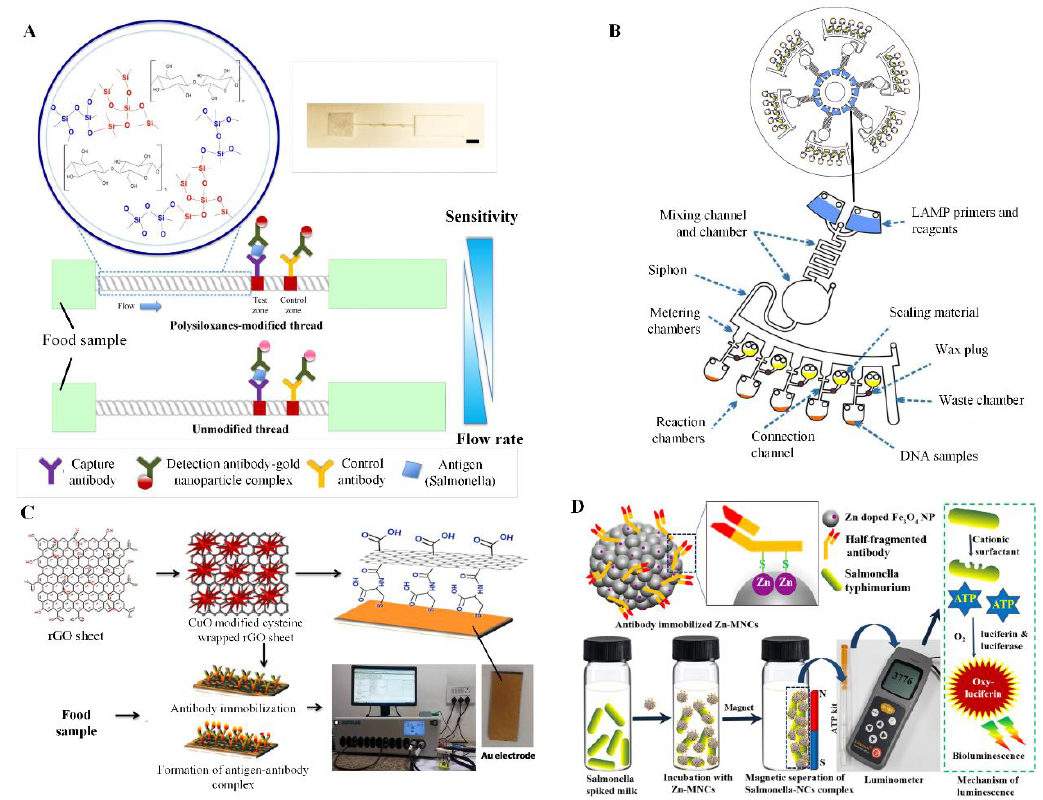
Figure 3. Other emerging point-of-care (POC) devices for food safety analysis. ( A ) A thread-based colorimetric device was developed for sensitive detection of Salmonella enterica in food samples such as milk, orange juice and lettuce. Adapted with permission from [86] © Elsevier (2018). ( B ) A disc-based loop-mediated isothermal amplification (LAMP) was developed for multiplexed fluorescent detection of foodborne pathogens, Escherichia coli , Salmonella sp. and Vibrio cholera , in chicken meat. Adapted with permission from [94] © Elsevier (2018). ( C ) A gold (Au) electrode coated with antibody immobilized graphene-wrapped copper oxide-cysteine hierarchical structure was introduced for sensitive electrochemical detection of Escherichia coli O157:H7 in food samples such as water, fruit juice and milk. Adapted with permission from [97] © Elsevier (2017). ( D ) A nanomaterial-based chemiluminescent device was developed for sensitive detection of Salmonella typhimurium in milk. Adapted with permission from [99] © Elsevier (2017). rGO: reduced graphene oxide; CuO: copper oxide; Zn-MNCs: Zinc-doped magnetic nanoclusters; Fe 3 O 4 NP: Iron oxide nanoparticle; ATP: adenosine triphosphate; O 2 :